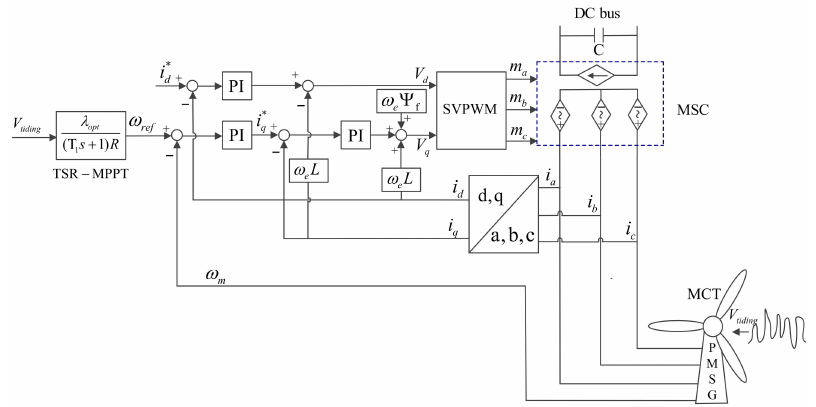
Figure 3. Control structure of the machine-side converter.